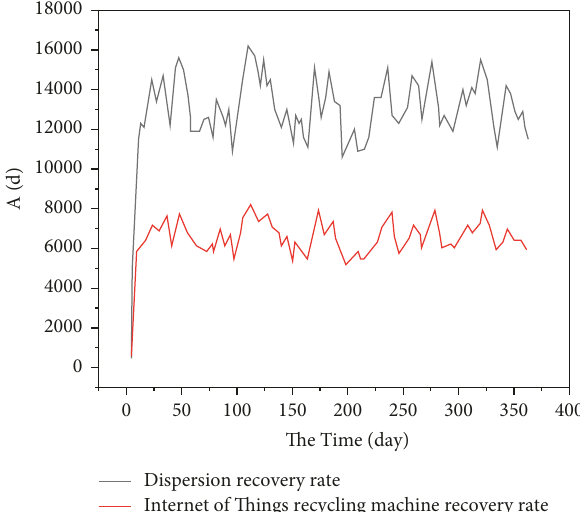
Figure 8: Cost recovering.